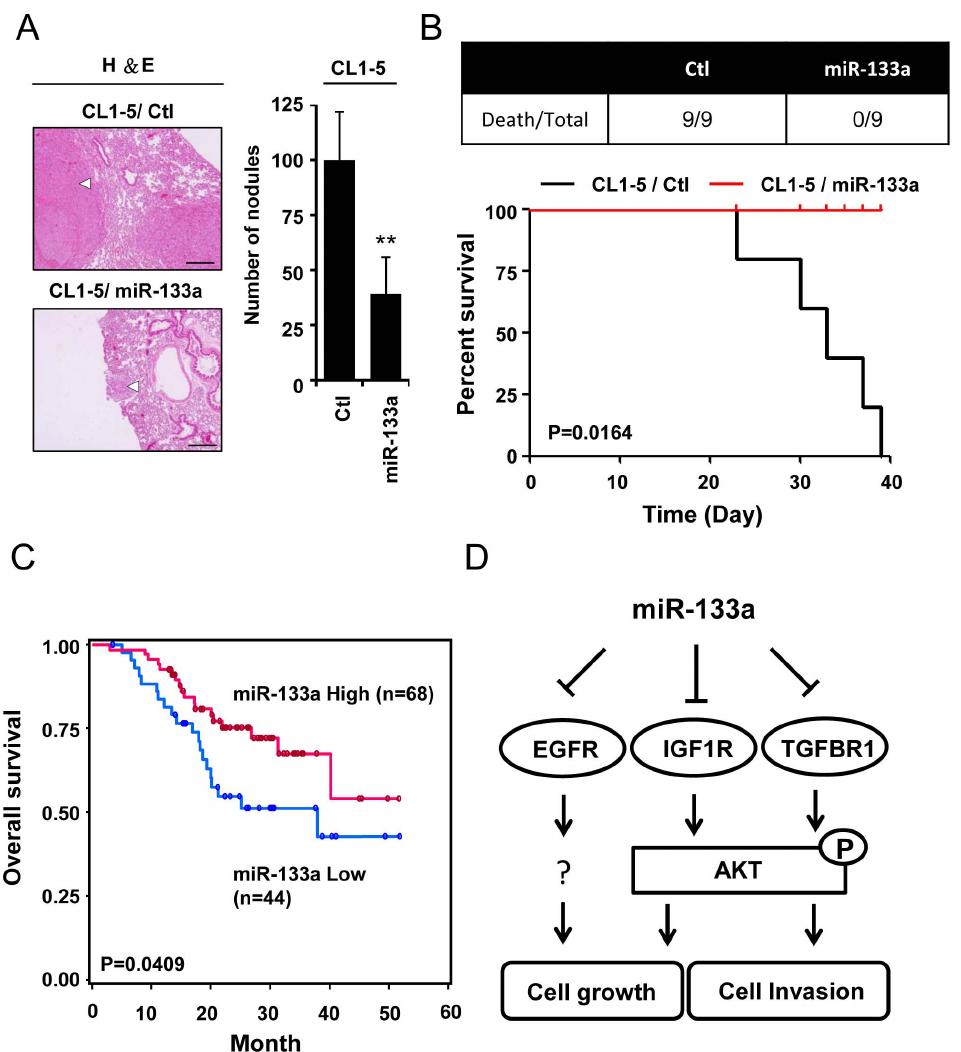
Figure 5. MiR-133a expression decreases cancer metastasis invivo and associates with longer survival rates in NSCLC patients. (A) Effects of miR-133a in metastasis in vivo . Left panel: histological examinations of the lung tumors by hematoxylin-eosin (H&E) staining. Representative lungs of mice intravenously (i.v.) injected with CL1-5/Ctl, CL1-5/miR-133a. White arrows indicate the lung tumors. Scale bars, 200 m m. Right panel: Numbers of metastatic tumor nodules were calculated 39 weeks after tail-vein injection (n=9 per group). (B) The number of death/total (top panel) and survival curve (bottom panel) in each group at 39 days after i.v. injection were presented. Data were expressed as the mean 6 SD by the log-rank (Mantel-Cox) test. P=0.0164 (C) Kaplan-Meier plots of overall survival in 112 NSCLC patients in high- and low-risk groups based on miR-133a expression levels (P=0.0409). (D) Model showing that miR-133a modulates the receptor-mediated cancer malignancy in NSCLC.